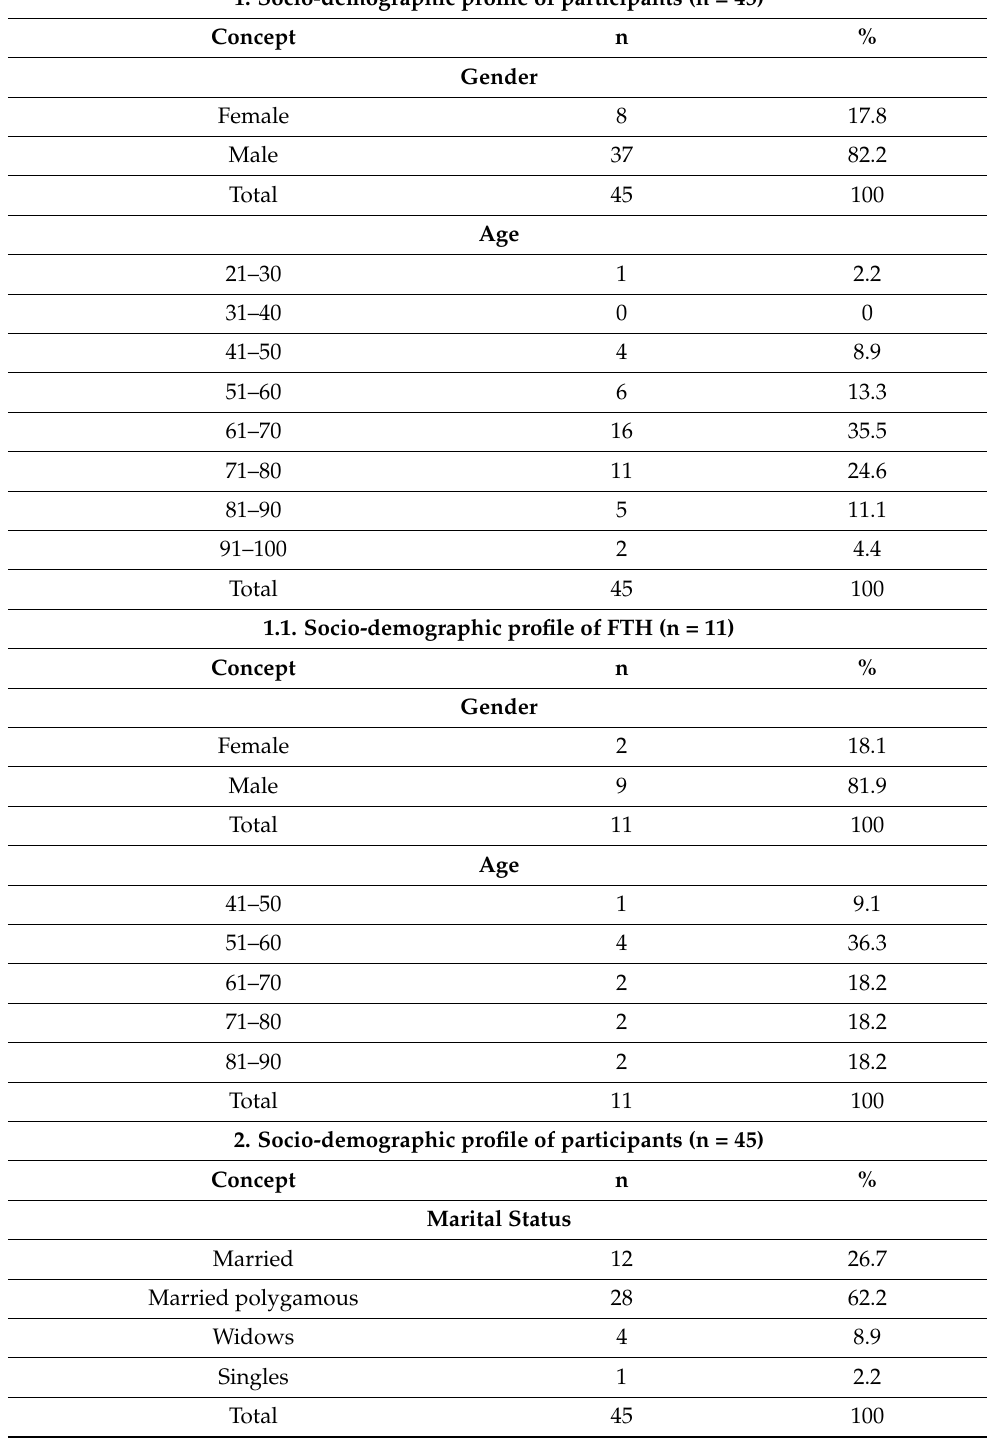
Table 4. Socio-demographic profile of participants (n = 45). 1. Socio-demographic profile of participants (n =